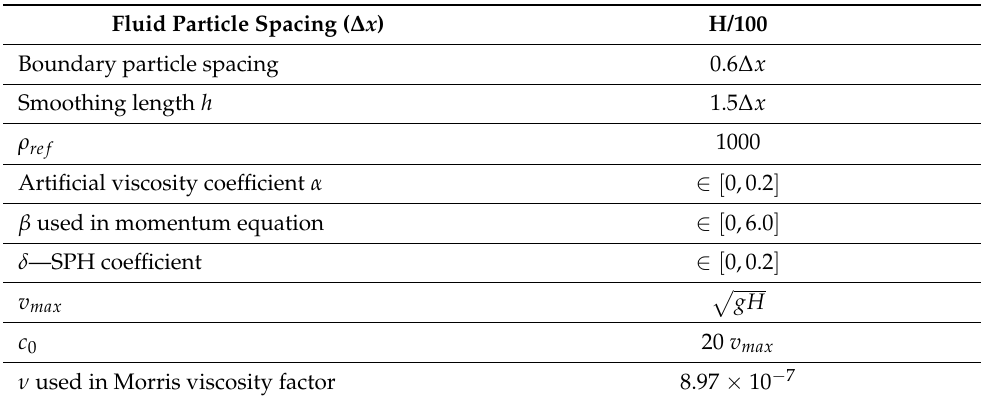
Figure 2. Schematic of the dam-break simulation tank with the associated dimensions. Table 1. Parameters and numerical setting used for the dam-break